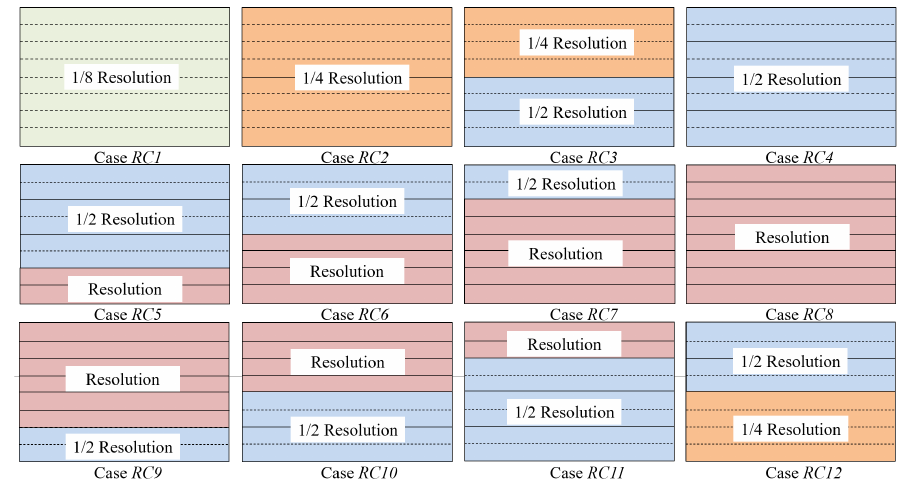
Figure 2. Resolution boundary adjusting scheme.